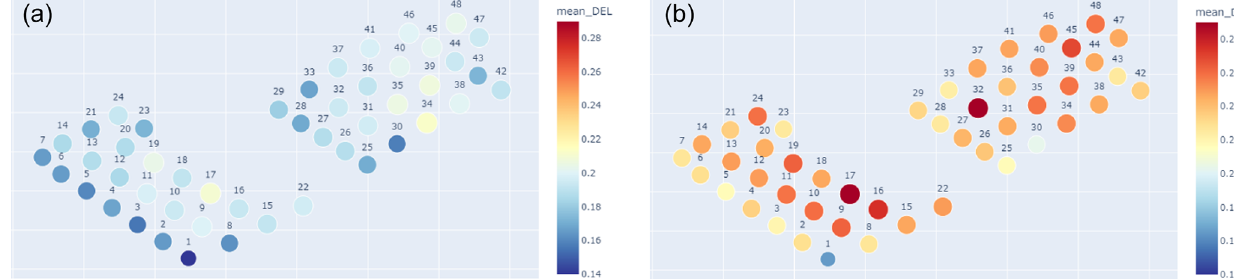
Figure 16. Mean DEL (ratio of the arithmetic mean of all 10min DELs and the maximum training DEL) farm-wide plot, normalized in relation to the highest training DEL value for (a) scenario F and (b) scenario D.